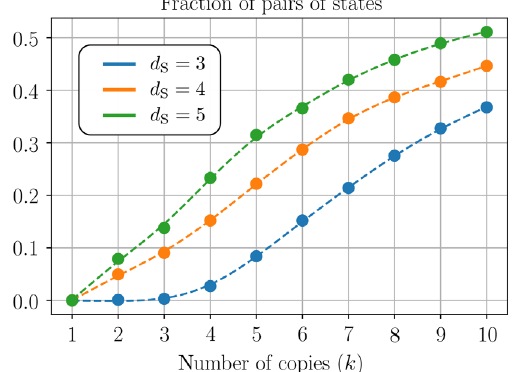
FIG. 2. An estimate of the volume of all block-diagonal pairs of ∝ 1 ; σ states ð ρ with H for which there is a transformation S S Þ S S taking ρ ⊗ i into σ ⊗ i for some i ≤ k , divided by the volume of all S S block-diagonal pairs that can be catalytically activated. Catalyti- cally activated pairs are such that (i) they satisfy the respective second laws and (ii) ρ cannot be directly converted into σ S